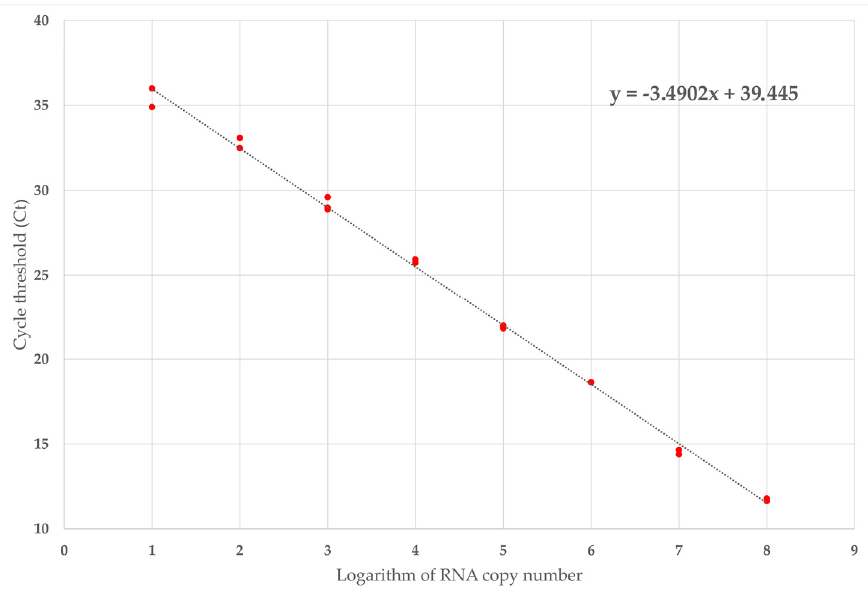
Figure 4. Absolute GLRaV-1 quantitation standard curve. Cycle threshold (Ct) values obtained for three replicates of ten-fold serial dilutions of GLRaV-1 control transcripts are plotted. The mathematical equation of the standard curve used for quantification and the coefficient of correlation (R 2 ) are indicated.